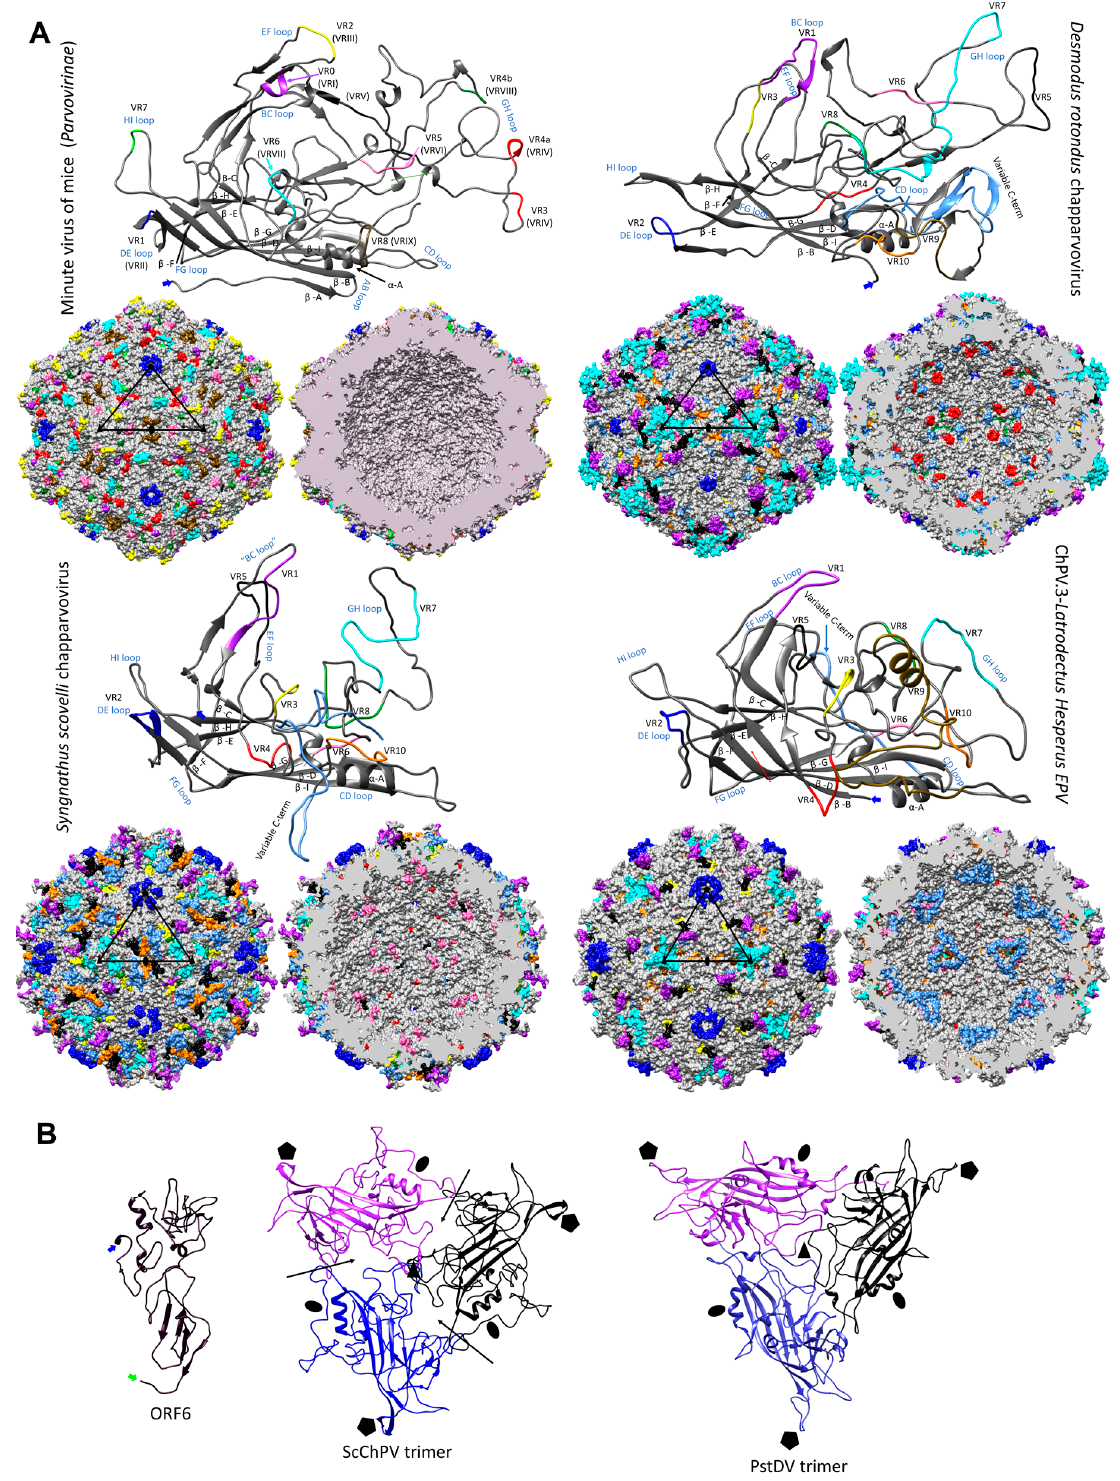
Figure 6. Structural variation and assembly interfaces of chapparvoviruses (ChPVs). ( A ) Comparison of VP monomer ribbon diagrams of the protoparvovirus minute virus of mice (PDB ID: 1Z14) from subfamily Parvovirinae to homology models of an amniote, a fish, and a ChPV-derived EPV from an arthropod genome (ChPV.3-LatHes). Variable regions (VRs) of the same number are marked by the same color and mapped to the surface and luminal area of the T = 1 icosahedral capsid model constructed of 60 monomers. In the case of the minute virus of mice, the VRs are marked by both the